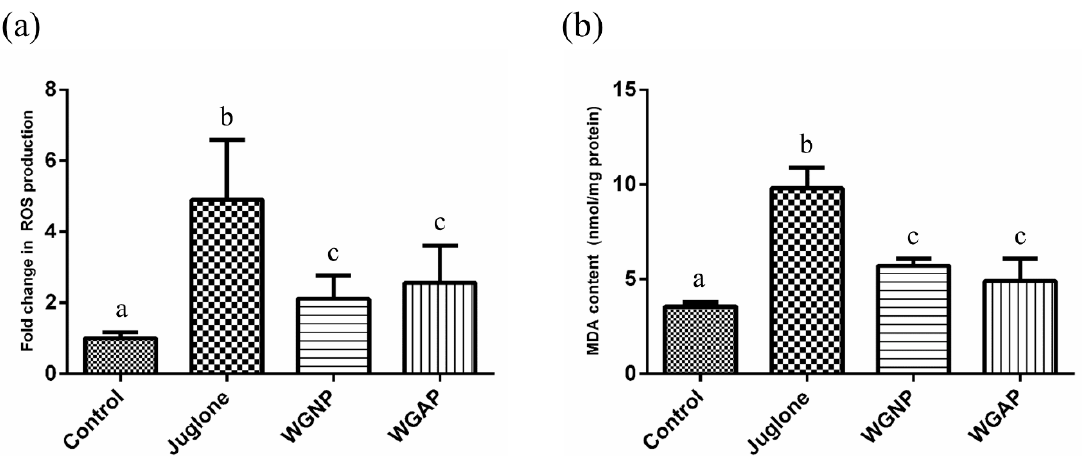
Figure 4. Antioxidant activities of WGNP and WGAP on Caenorhabditis elegans . ( a ) Fold change in reactive oxygen species (ROS) production, ( b ) malondialdehyde (MDA) content. All data are expressed as mean ± S.D. The different letters represent a statistical difference at p < 0.05 among the groups.